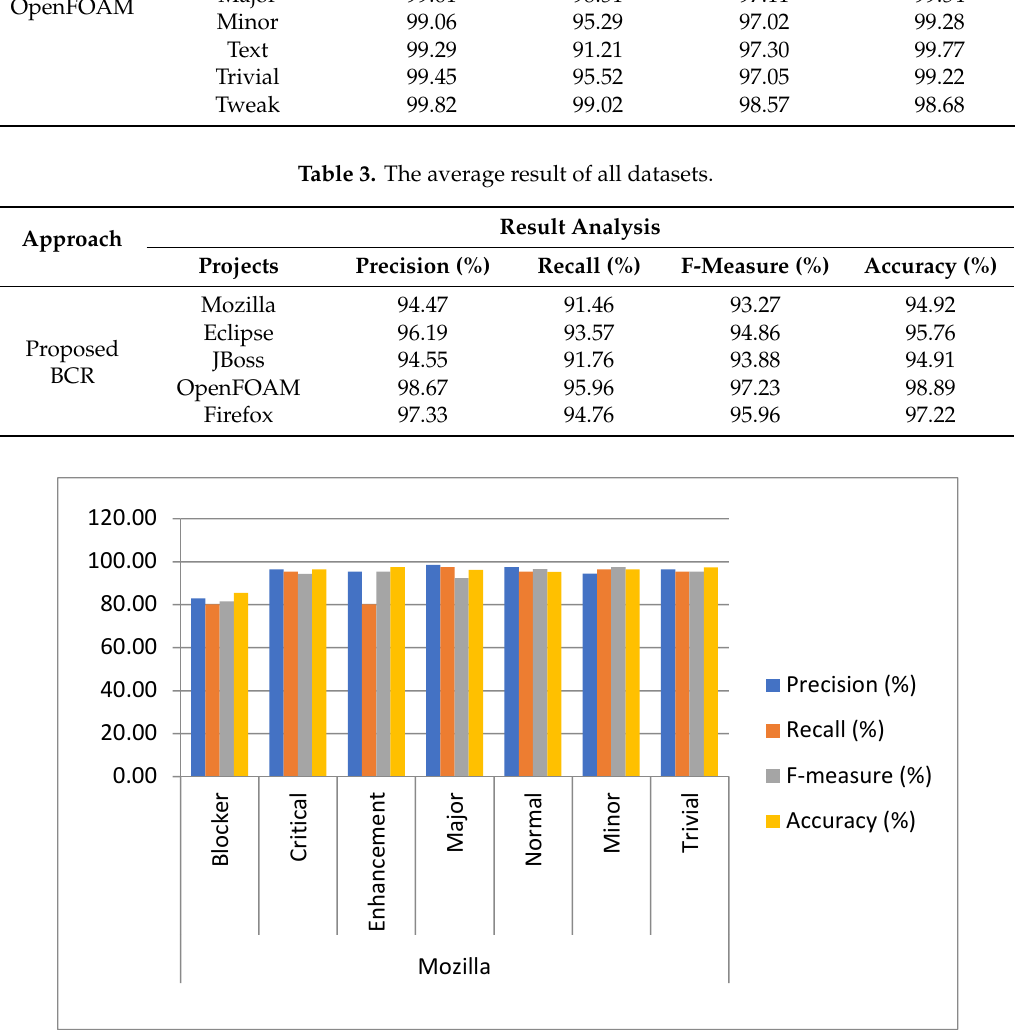
Figure 5. Results analysis of the proposed BCR on seven classes of the Mozilla Project.